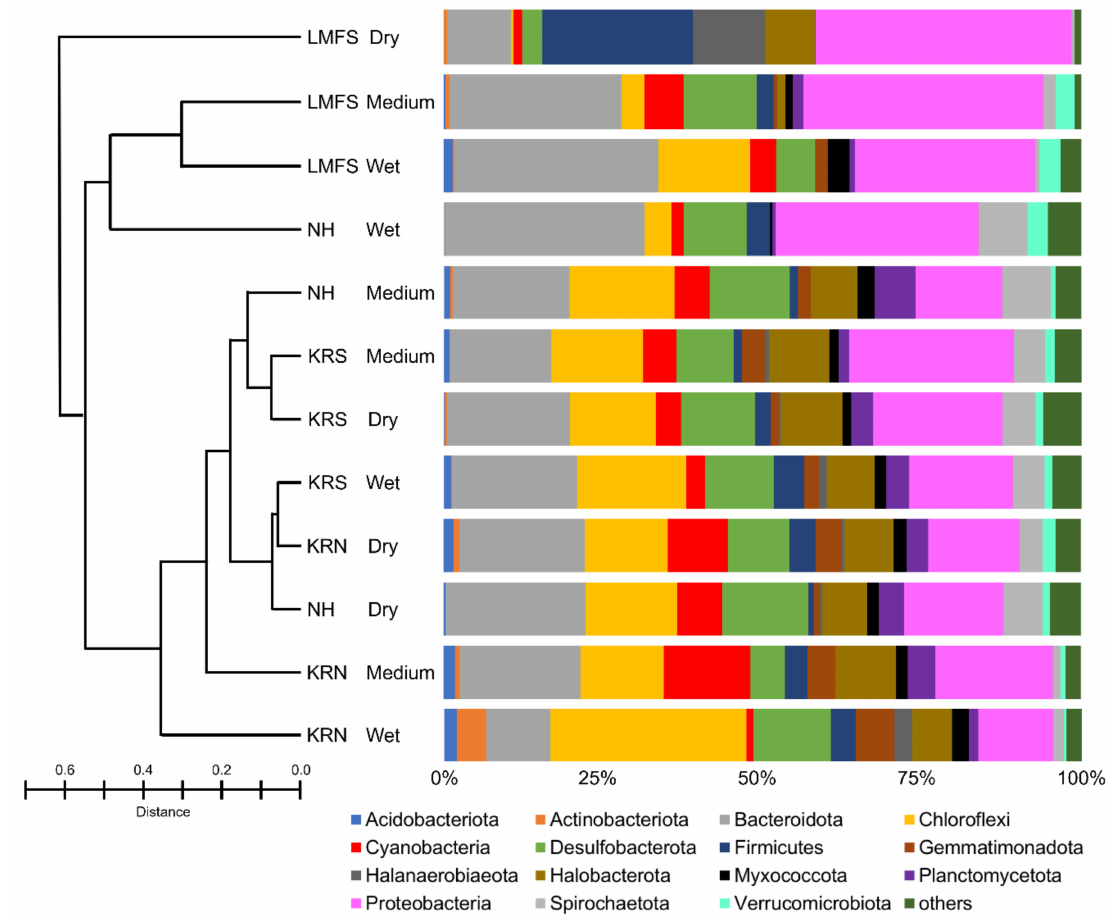
Figure 4. Bar plot showing the relative abundance (%) of amplified sequences of bacterial and archaeal phyla. Abundances were normalized to the total number of sequences, and taxonomic groups that were outside of the scope of research were grouped under the others category. The 15 most abundant orders across all samples are displayed in the legend. Bray–Curtis dissimilarity index is presented in the left